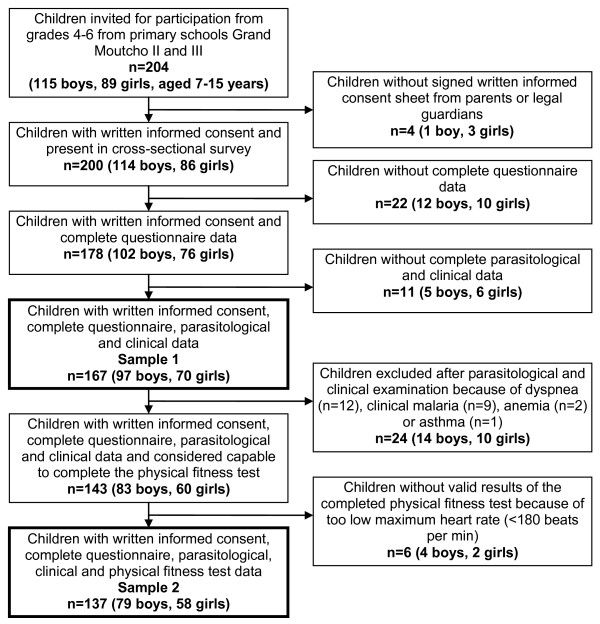
Flow chart detailing operational study results and the two different samples further considered in the analysis. The study was carried out in Grand Moutcho school, Agboville, Côte d'Ivoire, in early 2010.